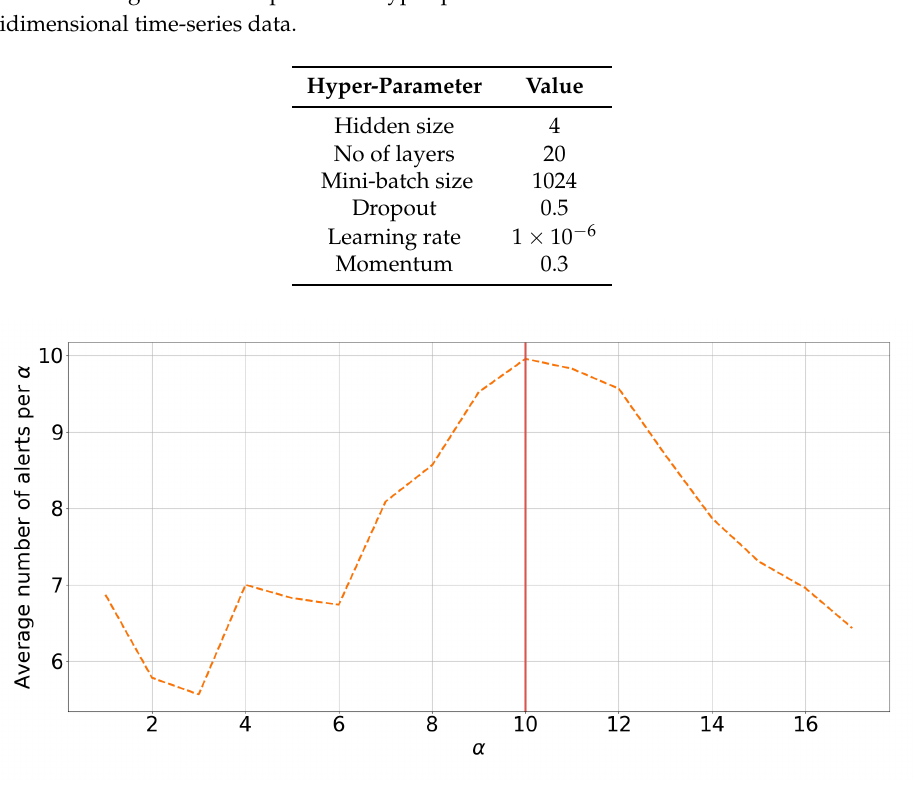
Figure 5. The average number of alerts raised, given an alert window start of α days and a size of β = 7, using the optimal threshold τ for each given α found using grid search on the anomaly detection used on Mahalanobis distances produced by a GRU-based